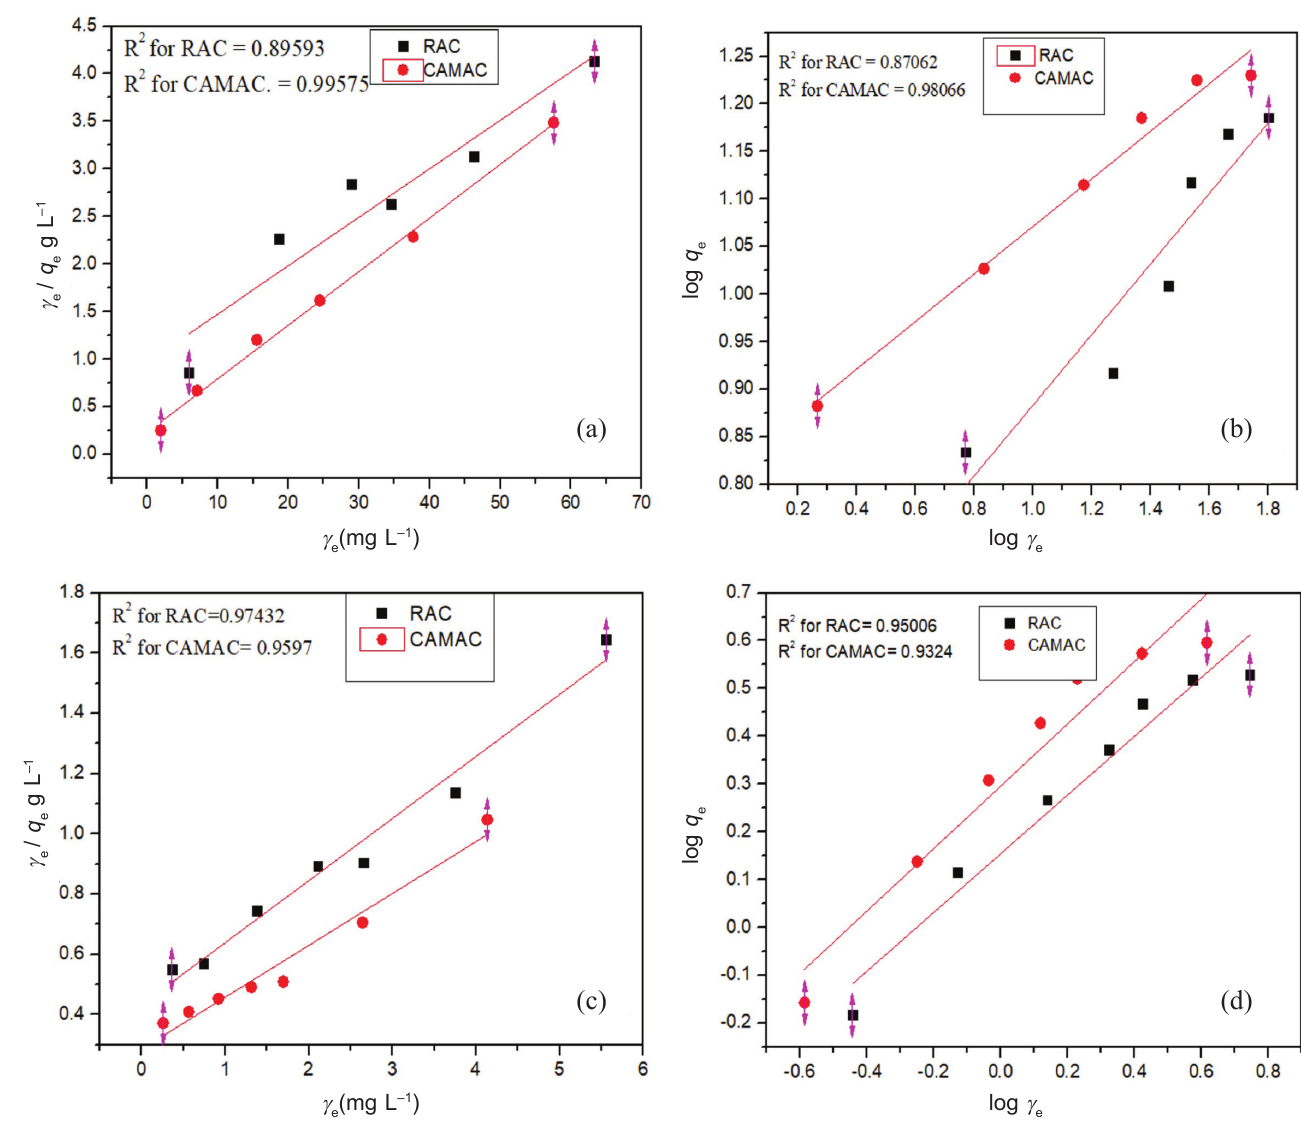
Fig. 10 – Langmuir adsorption isotherm of Cu(II) (a), As(III) (c), and Freundlich adsorption isotherm of Cu(II) (b), As(III) (d) onto RAC and